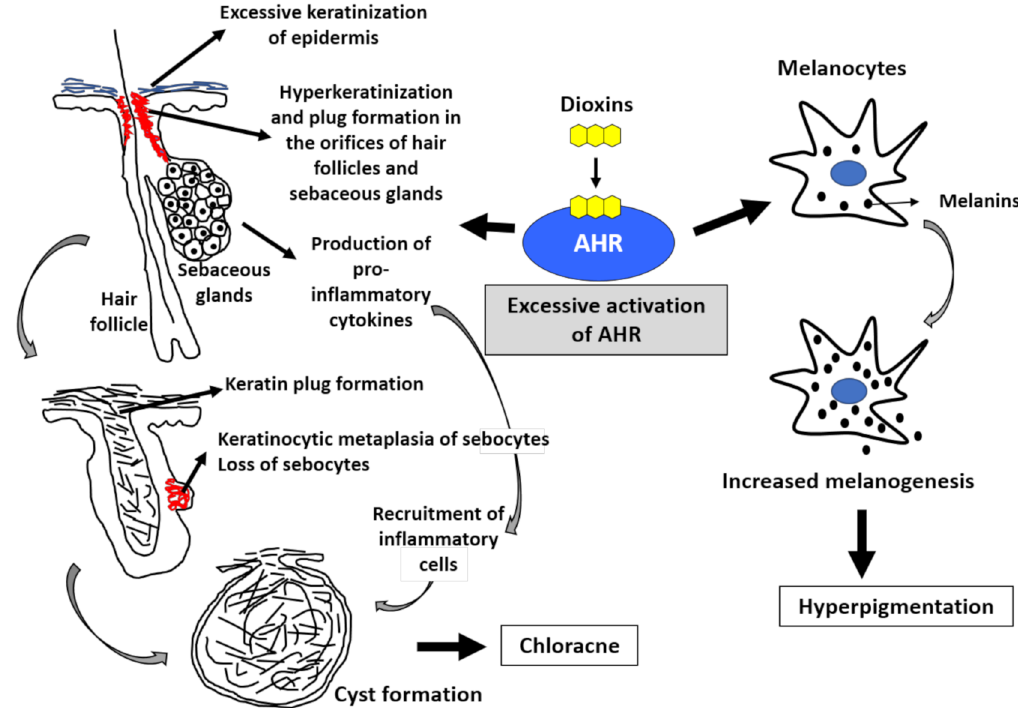
Figure 2. Excessive activation of aryl hydrocarbon receptor (AHR) by dioxins induces chloracne and hyperpigmentation. The activation of AHR induces keratinization (upregulated epidermal differentiation). Excessive activation of AHR by dioxins induces epidermal hyperkeratinization. It also induces hyperkeratinization and keratin plug formation in the orifices of hair follicles and sebaceous glands. Most importantly, excessive AHR activation induces keratinocytic metaplasia of sebocytes, impairs sebum production, and finally results in the loss of sebocytes. Hair follicles eventually form cystic appearance. Activation of AHR by dioxins also induces the production of proinflammatory cytokines and accelerates the recruitment of inflammatory cell infiltration. These epithelial alterations and inflammatory processes lead to the development of chloracne. Melanocytes produce melanins. Excessive AHR activation by dioxins upregulates melanogenesis, and hyperpigmentation